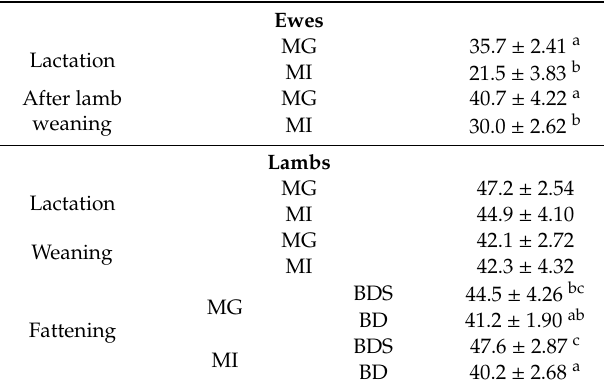
Table 7. Plasma antioxidant status of ewes and lambs (ABTS • + , mmol Trolox / mL plasma).